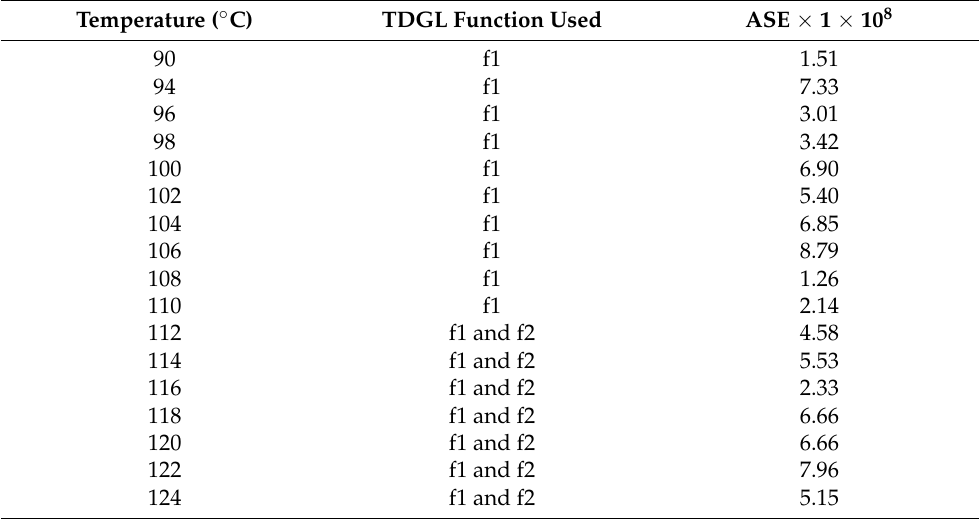
Table 1. Number of functions used for each temperature and the ASE values obtained in each